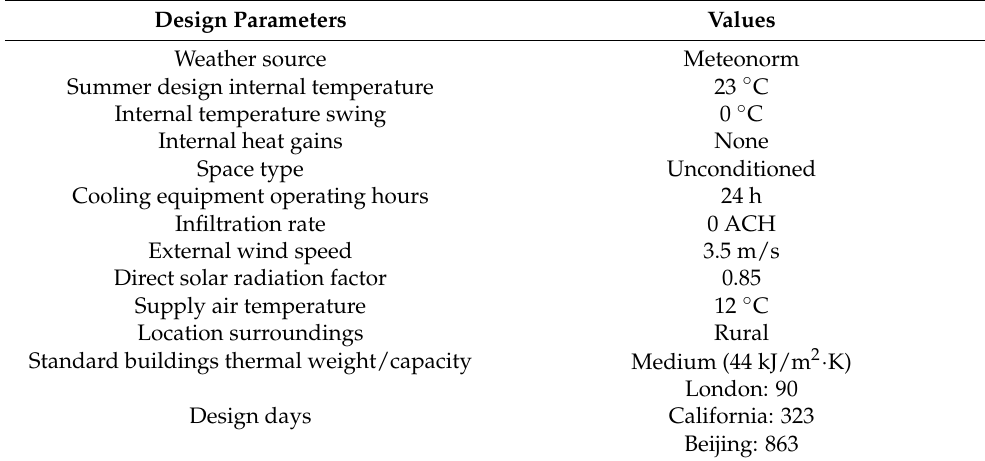
Table 3. Design conditions for the proposed building.